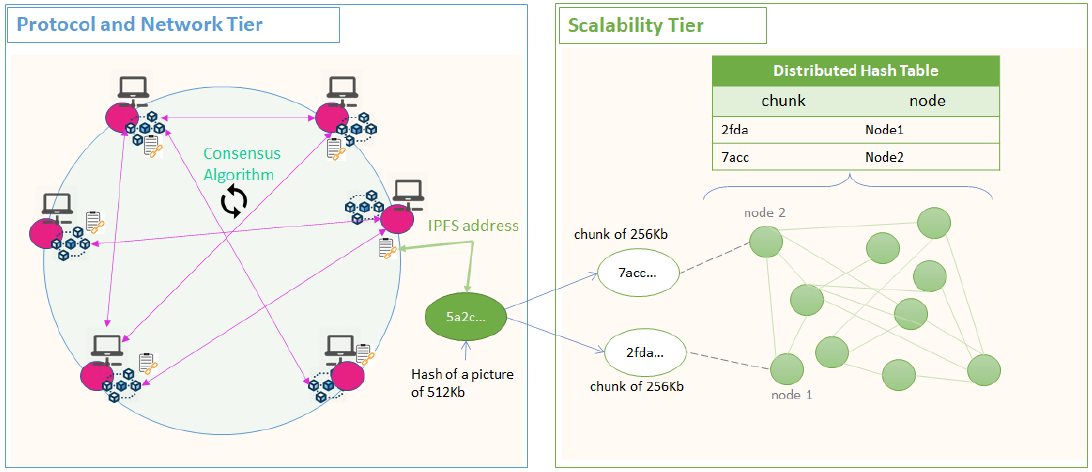
Figure 4. Scalability Tier—File System Storage Mechanism.